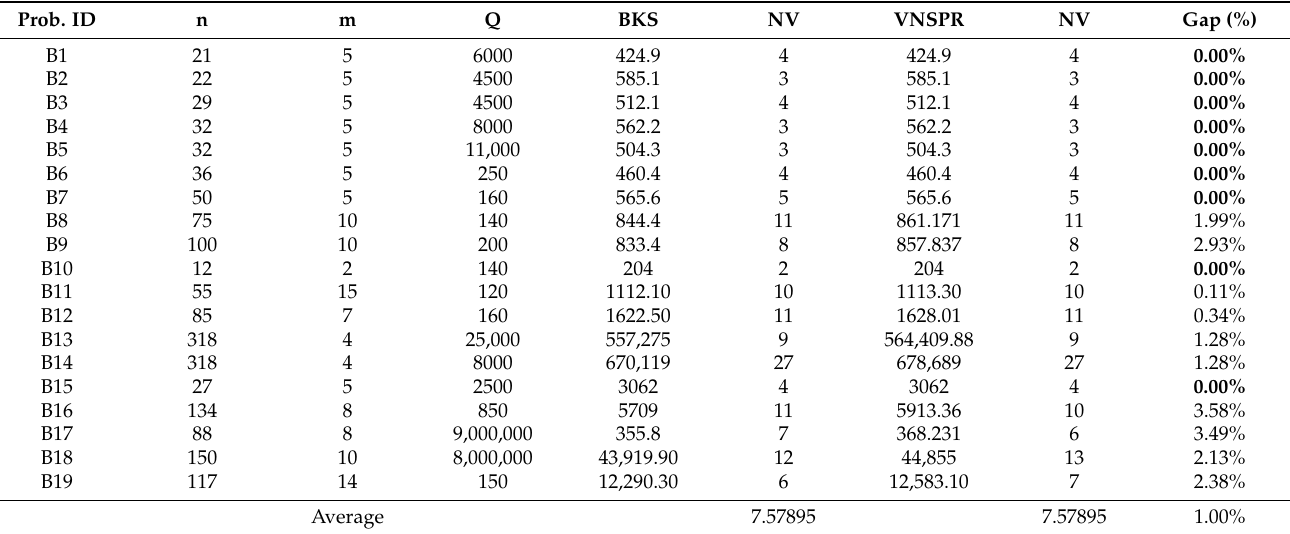
Table 6. Computational results for LRP with time windows for Barreto’s instances.